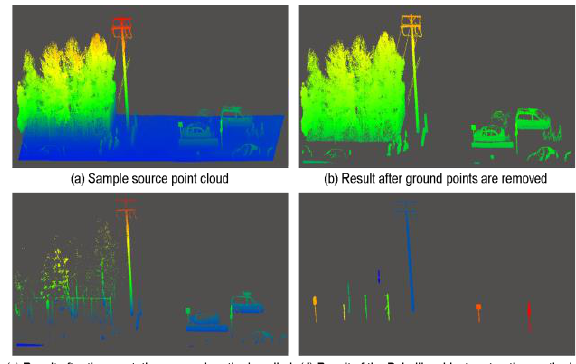
Figure 8. A step by step result of a sample point cloud with the proposed methods